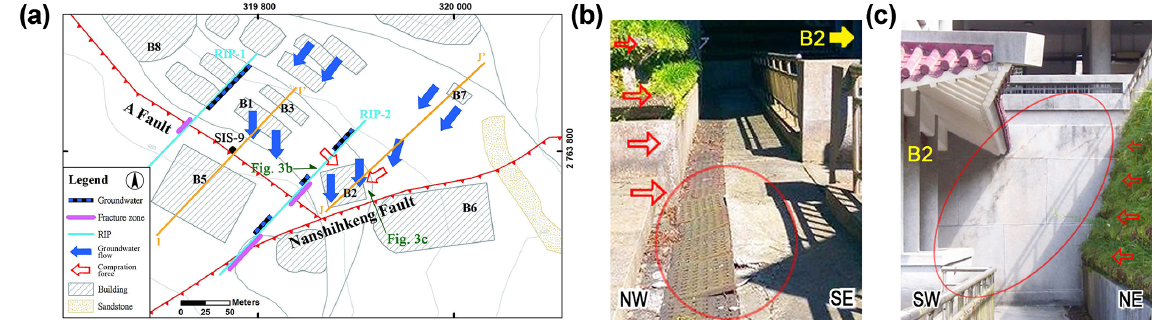
Figure 3. Hydrogeological map (a) . Two 2-D RIP across the fault zone (i.e., A Fault) were carried out parallel to each other. The blue solid arrows indicate groundwater flow directions, line I-I’ represents a hydrogeological profile and is shown in Fig. 5, and line J-J’ represents the cross-section profile for slope stability analyses shown in Figs. 15 and 16. In Fig. 3b and 3c, red hollow arrows represent directions of compressive stress resulting from slope sliding, and buckles of ground and cracks on walls occurred consequently.